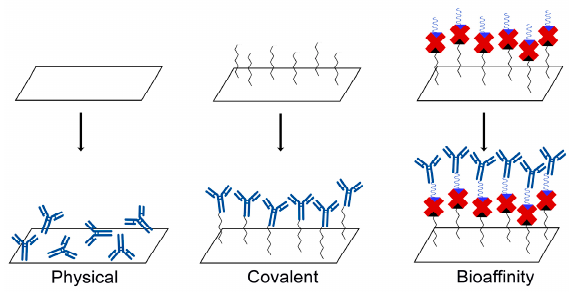
Figure 2. Antibodies immobilization techniques for biosensor construction.